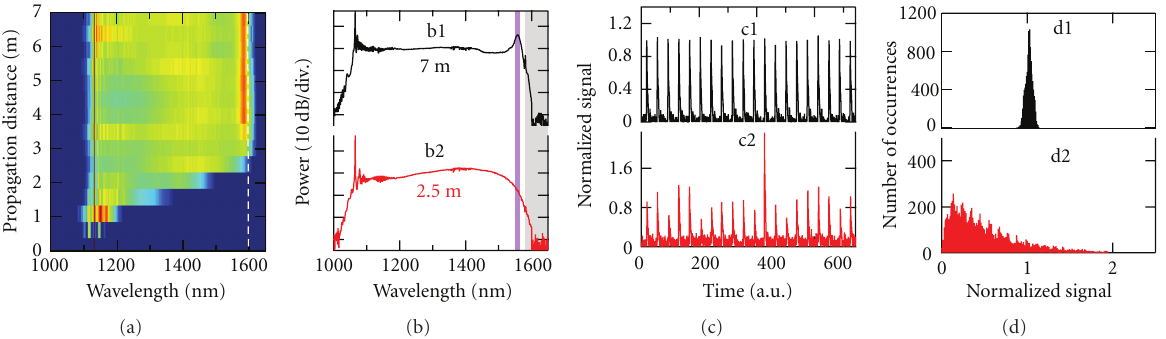
Figure 11: (a) Measurement of the spectral broadening as a function of propagation distance in the solid-core PBG fiber 3. The white dashed line represents the PBG edge. (b) Measured spectra for a fiber length of 7m (b1) and 2.5m (b2). (c1 and c2) Samples of corresponding pulse train recorded after a 10 nm bandpass spectral filtering at 1550 nm (depicted by the purple region in (b)). (d1 and d2) Corresponding statistical distribution of the signal amplitude over 10,000 records. The signal amplitude is normalized to the average over the 10,000